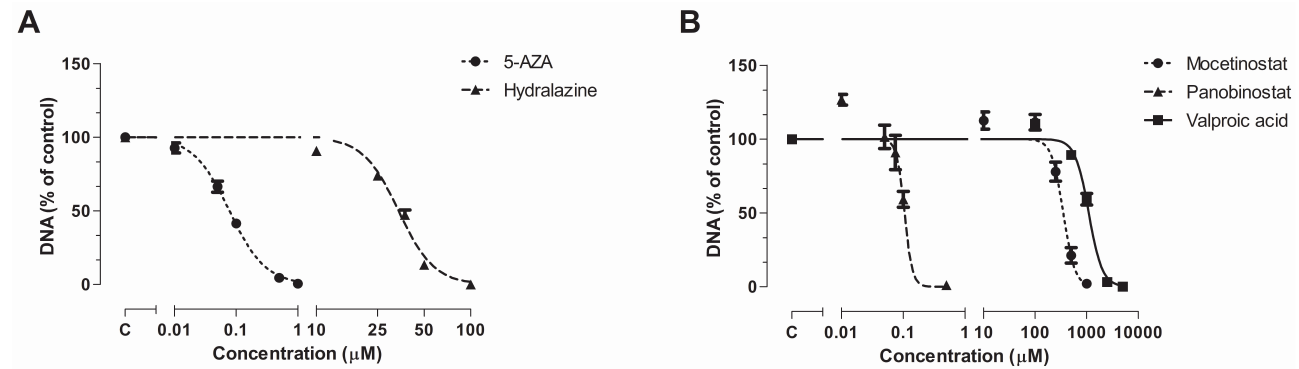
Figure 1. Antiproliferative effect of epi-drugs. Dose-response curves of ( A ) the DNMTis 5-AZA and hydralazine an ( B ) the HDACis mocetinostat, panobinostat, and VPA on total DNA, as a measure of cell number, in KPC3 cells after seven days of treatment. Values represent mean ± SEM of at least two independent experiments in quadruplicate and are shown as the percentage of control.